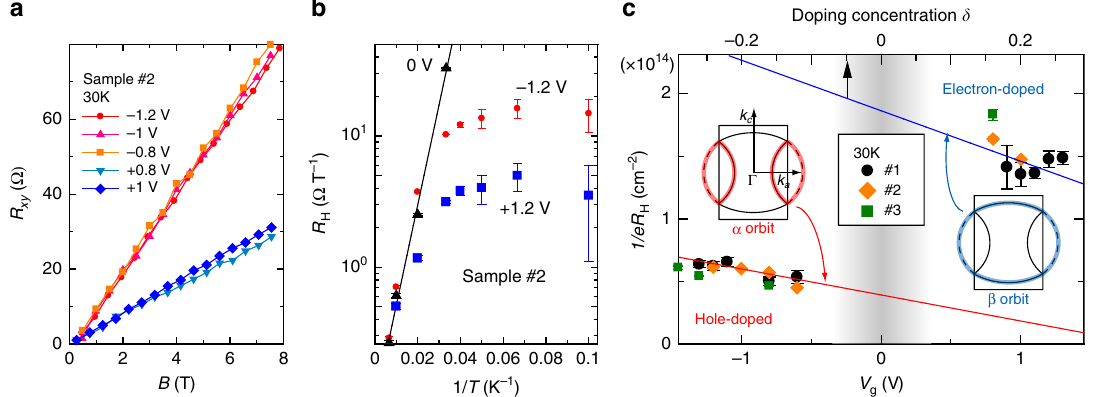
Figure 3 | Hall effect. ( a ) Hall resistance versus magnetic field at 30K. ( b ) Temperature dependence of R H at V g ¼ (cid:2) 1.2, 0 and þ 1.2V. The solid line represents the fit 8.78 (cid:3) 10 (cid:2) 2 (cid:3) exp ( E a / k B T ) O T (cid:2) 1 with an activation energy E a / k B ¼ 176K to the data of the undoped bulk crystal. The error bars were calculated from the s.d. of the Hall resistance versus magnetic field plots. Note that the data below 25K contain further errors owing to the non-ohmic behaviour (Supplementary Note 6). ( c ) Gate voltage dependence of 1/ eR H at 30K. Data from three different samples are shown. The solid lines denote the 1/ eR H estimated from the volume bounded by the non-interacting FS (blue) and by the lens-like closed portion of the FS (red). Namely, the blue and red solid lines represent densities of the total carriers and the partial carriers enclosed by the lens-like closed portion, respectively. Here, the electron doping concentration d is related to the non-interacting hole density n ( ¼ 1 (cid:2) d ) which is evaluated for the anisotropic Hubbard model with U ¼ 0. On the basis of the FET and EDLT measurements, the top horizontal axis is set in that d ¼ 0.2 corresponds to V g ¼ 1V (see Supplementary Note R H , which indicates the FS topology. The magnetic field B